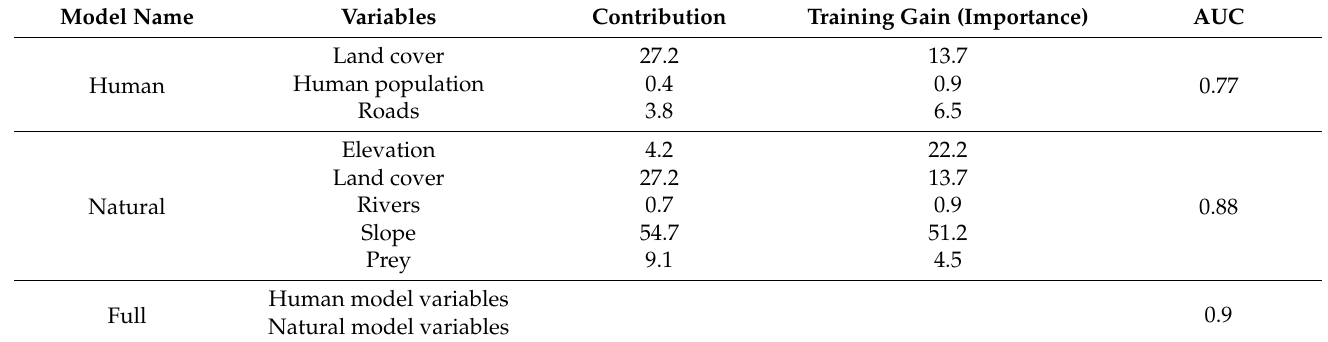
Table 4. Summary of model fit to predict leopard habitat distribution, estimates of variable relative contributions, and the importance training gain of the environmental variables to the Maxent model.